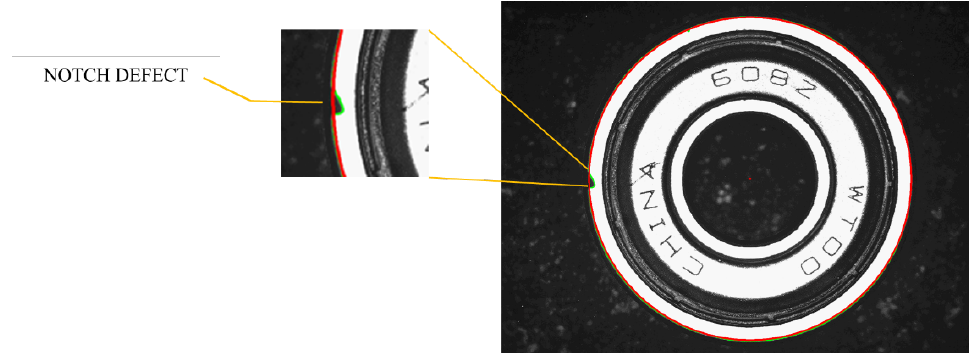
Figure 4. Schematic diagram of a notch defect.